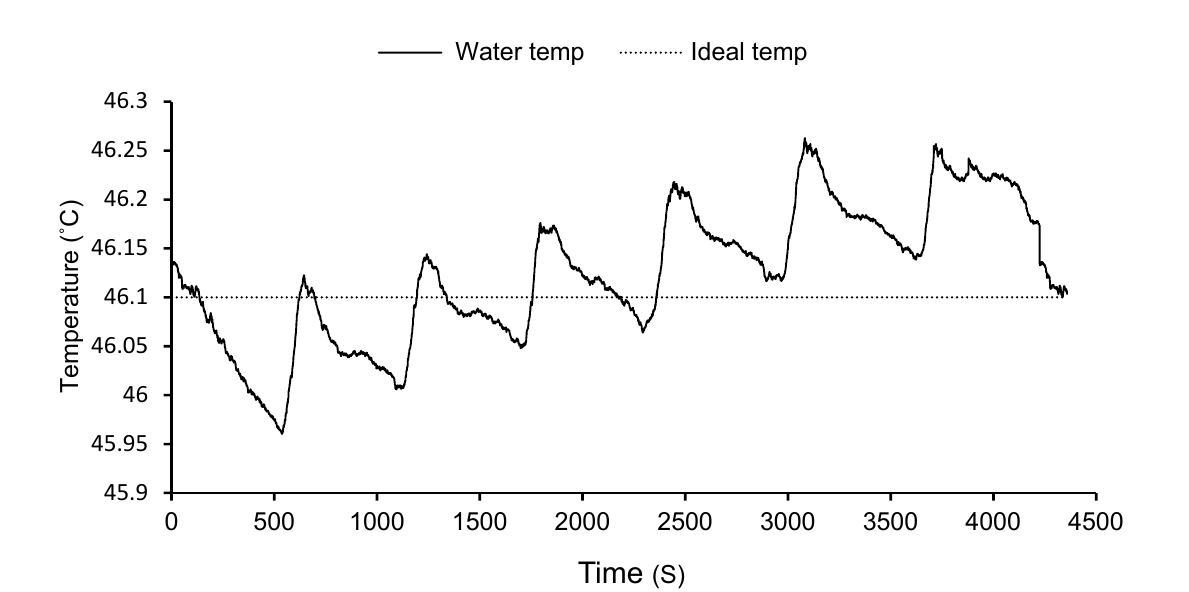
Figure 1. Mean temperature of water in hot water treatment tank recorded every second during the treatment process. The temperature range for this particular treatment was 45.96–46.26 °C with an average temperature of 46.12 °C.